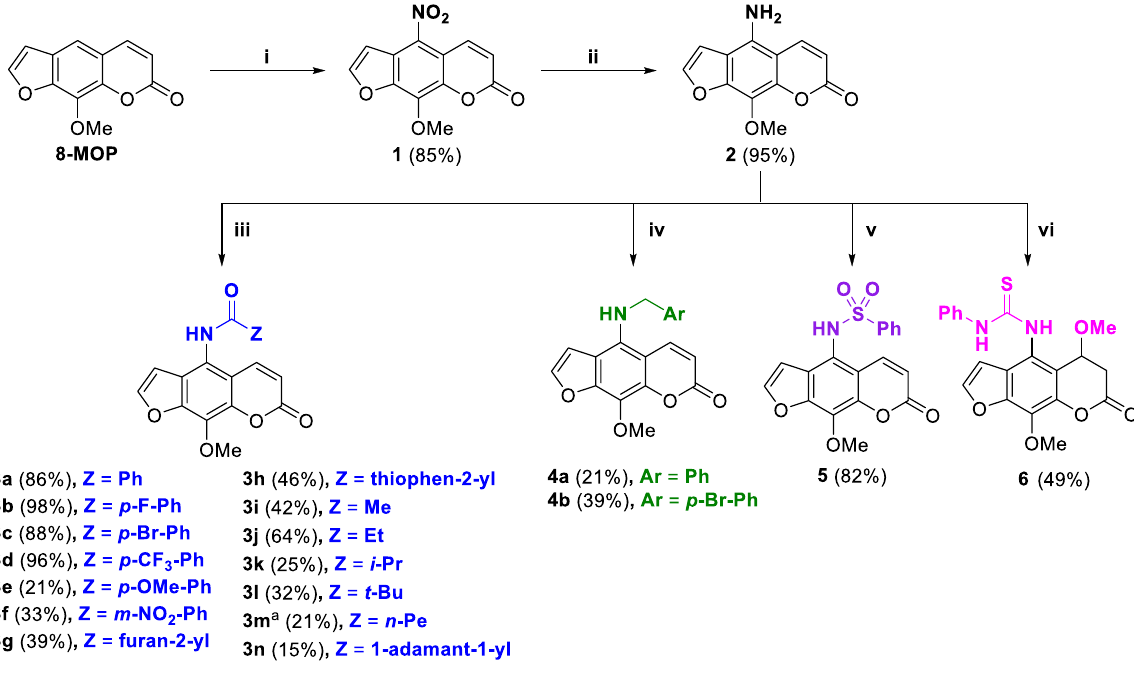
Figure 2. Synthesis of psoralen derivatives. (i) conc. HNO 3 , CH 3 COOH, rt; (ii) Sn (10.0 equiv.), 12 M HCl, EtOH, rt; (iii) acid chlorides (2.0–4.0 equiv.), K 2 CO 3 (1.5 equiv.), DCM, rt or acetic anhydride (10.0 equiv.), K 2 CO 3 (2.0 equiv.), pyridine (2.0 equiv.), cat. DMAP, DCM, rt; (iv) benzyl bromide (1.2–1.8 equiv.),